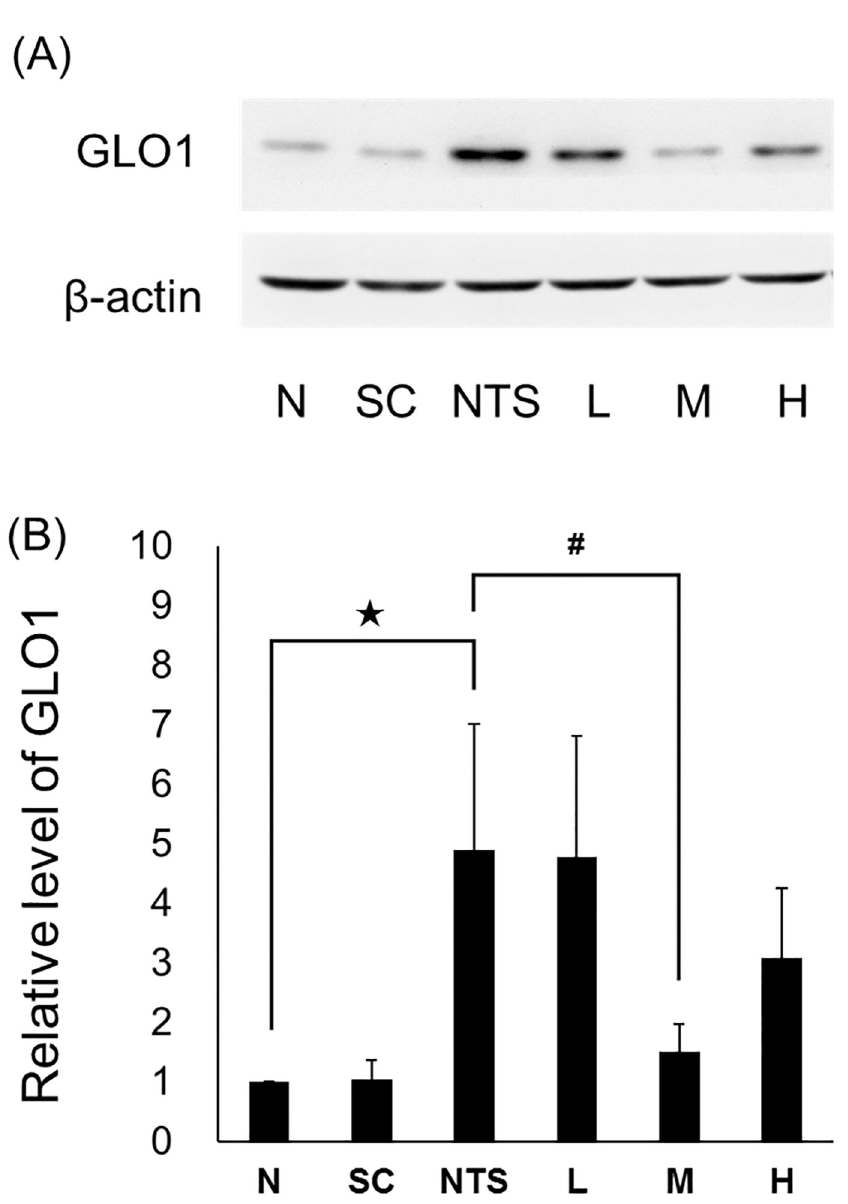
Fig 10. Immunoblotting analysis of glyoxalase 1 in renal homogenates from different experimental groups on day 15. N: normal group, SC: saikosaponin C control group, NTS: nephrotoxic serum control group, L: SSC 5 mg/kg/day treatment group, M: SSC 10 mg/kg/day treatment group, H: SSC 20 mg/kg/day treatment group. $ p < 0.05 compared to normal group, # p < 0.05 compared to NTS control group.